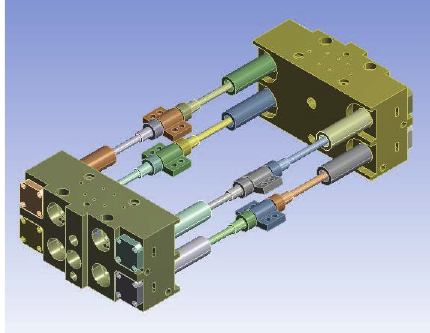
Figure 3: Simplified 3D model of hydraulic piston pump